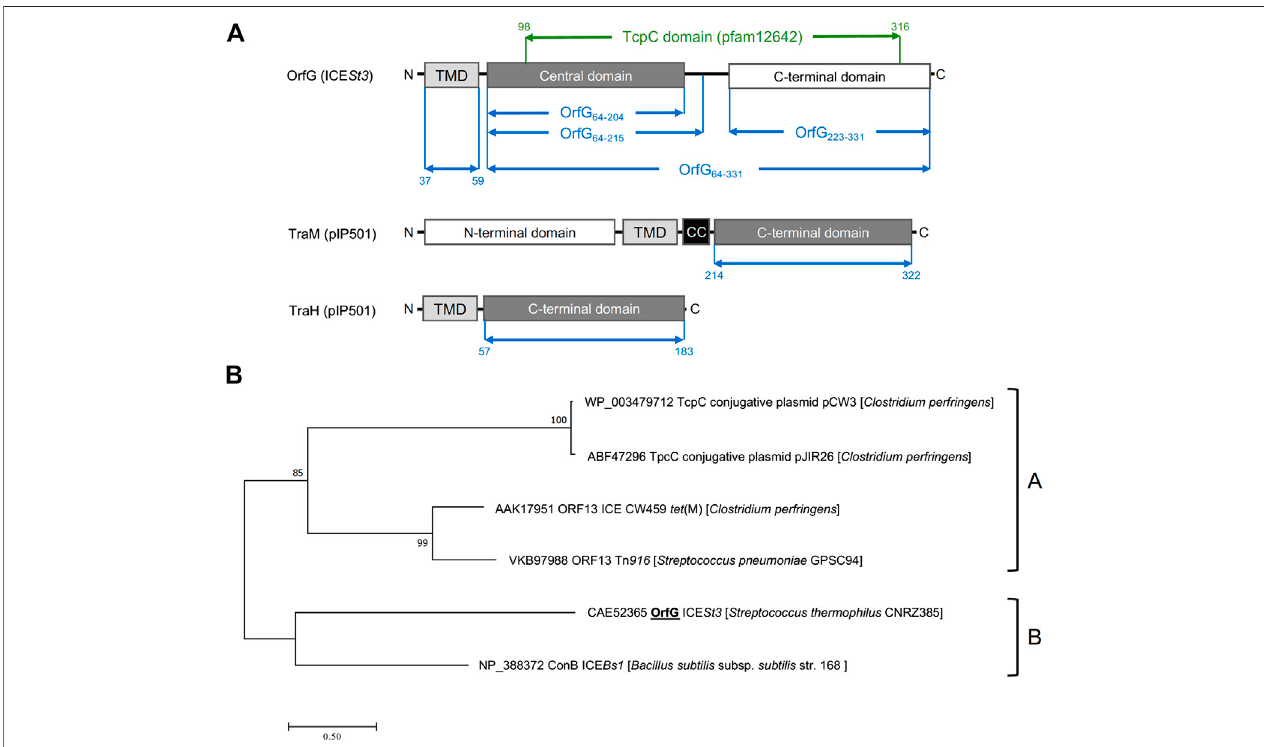
FIGURE 1 | OrfG belongs to the TcpC superfamily (A) Schematic representation of OrfG, TraM and TraH subdomains organization. Boundaries of OrfG subdomains and TraM and TraH NTF2-like domains are stated. TMD for transmembrane domain; CC for coiled-coil domain (B) Phylogenetic tree of representative members from the TcpC superfamily including OrfG. This tree was inferred by using the Maximum Likelihood method based on the JTT matrix-based model (Guindon etal.,2010).Thepercentage oftreesinwhichtheassociatedtaxaclusteredtogetherisshownnexttothebranches.Thetreeisdrawntoscale,withbranchlengths measured as the number of substitutions per site. All positions containing gaps and missing data were eliminated. There was a total of 284 positions in the fi nal dataset. Evolutionary analyses were conducted using MEGA7 (Tamura and Nei, 1993).